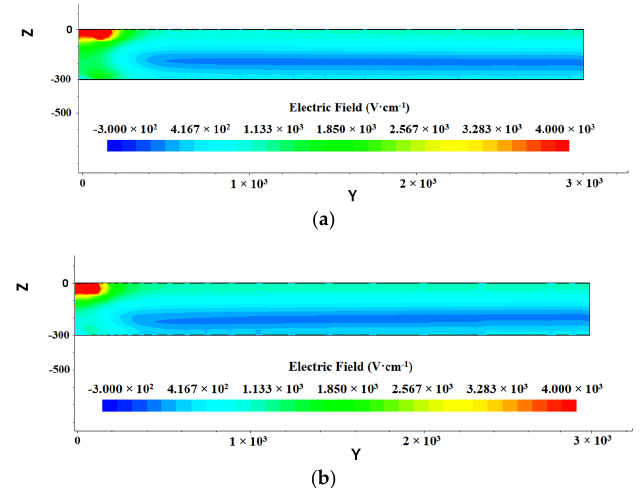
Figure 7. Internal electric field distribution of SDD: ( a ) gap 10 µm; ( b ) gap 25 µm.